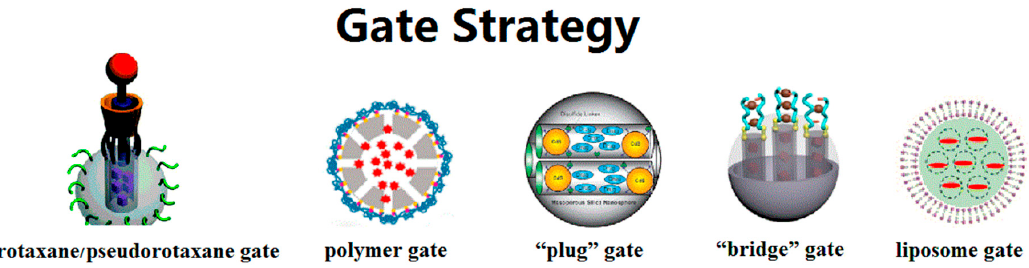
Figure 2. Schematic diagram of different types of gate strategies. Adapted with permission from